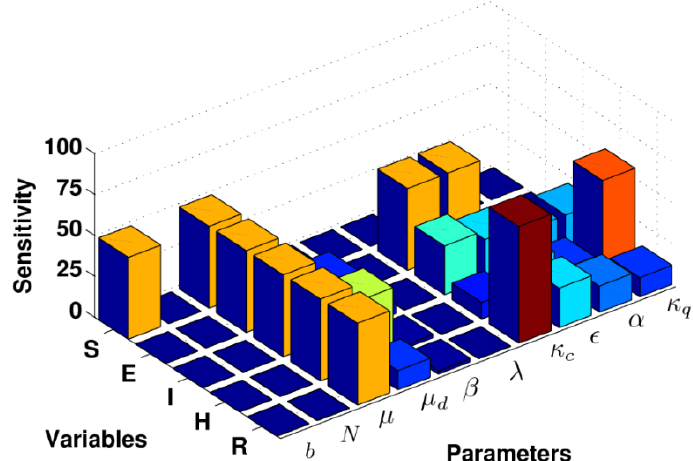
Figure 5. Local sensitivity analysis with half-normalization technique of all variables with respect to all parameters in computational simulations using